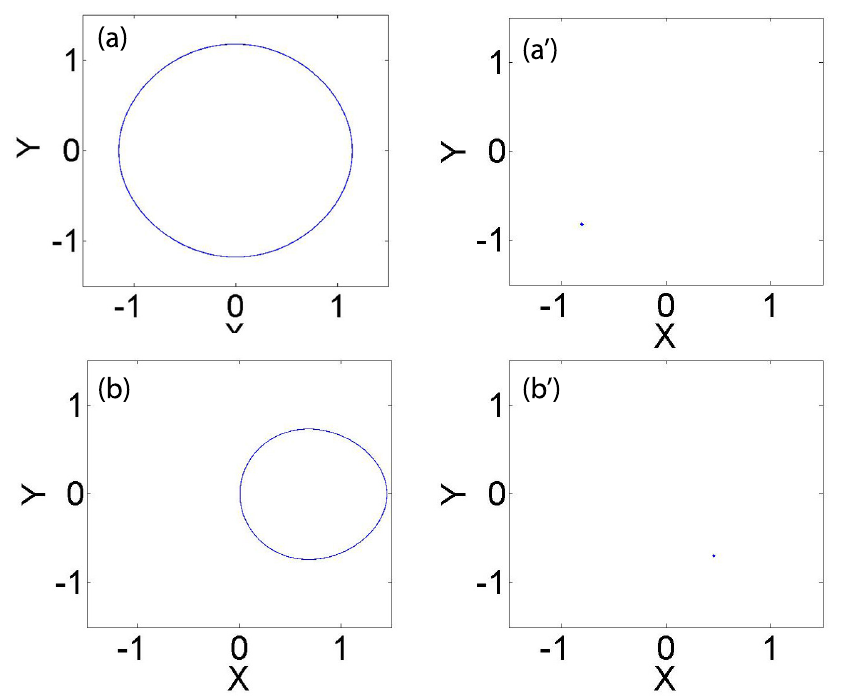
Figure 2. Numerical plots of the periodically driven pendulum with a torque, which equation is ¨ φ + α ˙ φ + sin φ = ν + f sin ω t . We chose the parameter values α = 0.15, ω = 1, and different values of ν . ( a , b ) Trajectories; ( a’ , b’ ) stroboscopic maps. The effect of the torque is observed in ( a , a’ ), where ν = 0, and in ( b , b’ ), where ν = 0.55. Here, X and Y represent angular displacement and velocity,